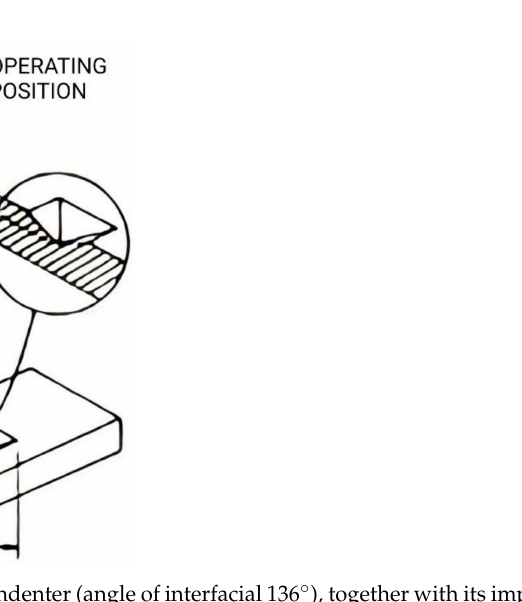
Figure 10. Some details of the Vickers indenter (angle of interfacial 136 ◦ ), together with its impression, where d is the diagonal’s average length in µ